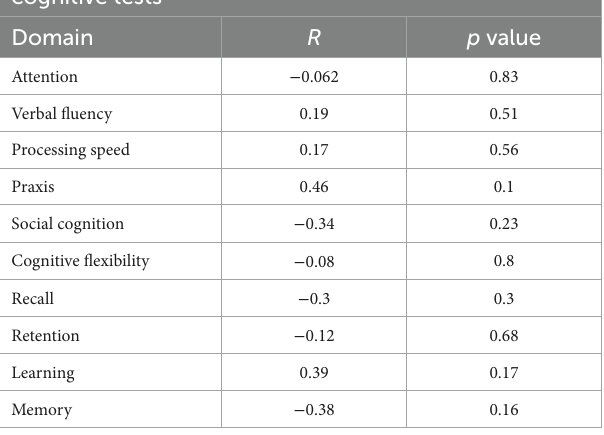
TABLE 2 There is no correlation between PPI and cognitive performance by older adults. Correlation between PPI and performance in the cognitive